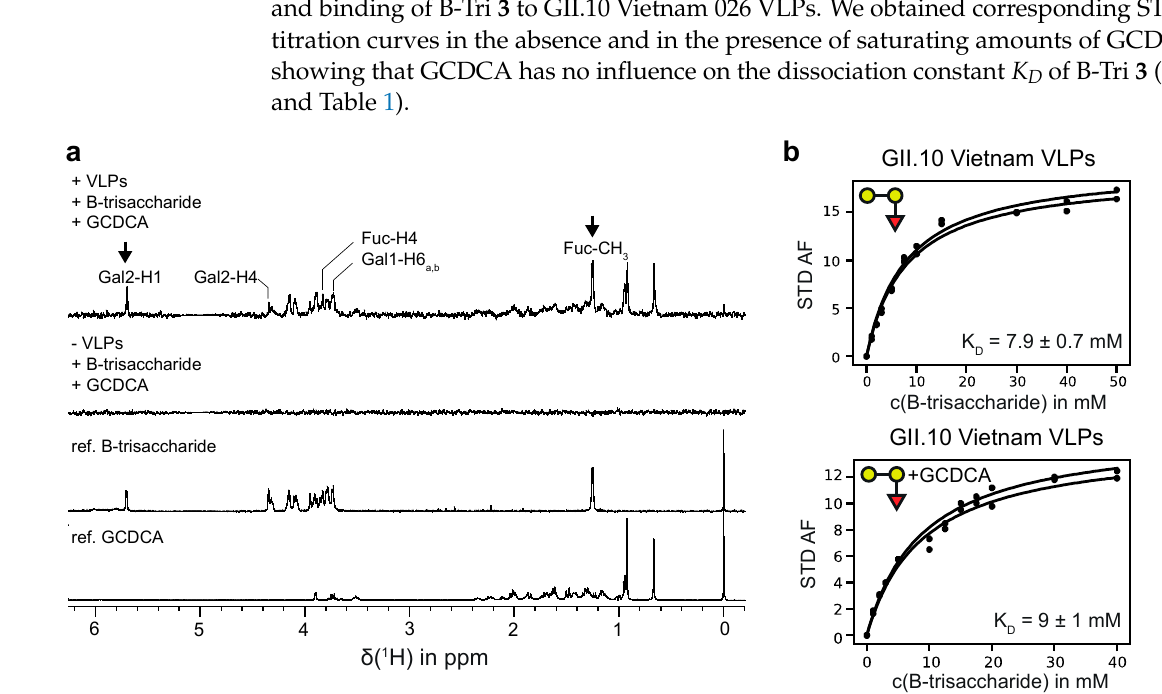
Figure 2. ( a ) STD NMR experiments for a sample of GII.10 Vietnam 026 VLPs (0.87 mg/mL) and 2 mM B-trisaccharide 3 in the absence and presence of saturating amounts of GCDCA (1 mM). For water suppression an excitation sculpting sequence [54] was used. The signals of the anomeric protons of β -D-galactose (Gal1) and α -L-fucose (Fuc) are hidden by the water signal (suppressed). The arrows denote the signals of the anomeric proton of the α -D-galactose residue (Gal2) and of the C6-methyl group of the α -L-fucose residue (Fuc) of 3 . The STD intensities of these signals were used for the determination of dissociation constants from STD NMR titration experiments. (b ) Binding isotherms for H1 of Gal2 and the C6-methyl group of Fuc of 3 in the absence (left) and in the presence of GCDCA (right). Samples contained 0.95 mg/mL or 0.87 mg/mL GII.4 Vietnam 026 VLPs according to the absence or presence of GCDCA, respectively. All samples were prepared in PBS buffer (8% D 2 O) at a pH* of 7.20. NMR experiments were acquired at 600 MHz at a temperature of 277 K.